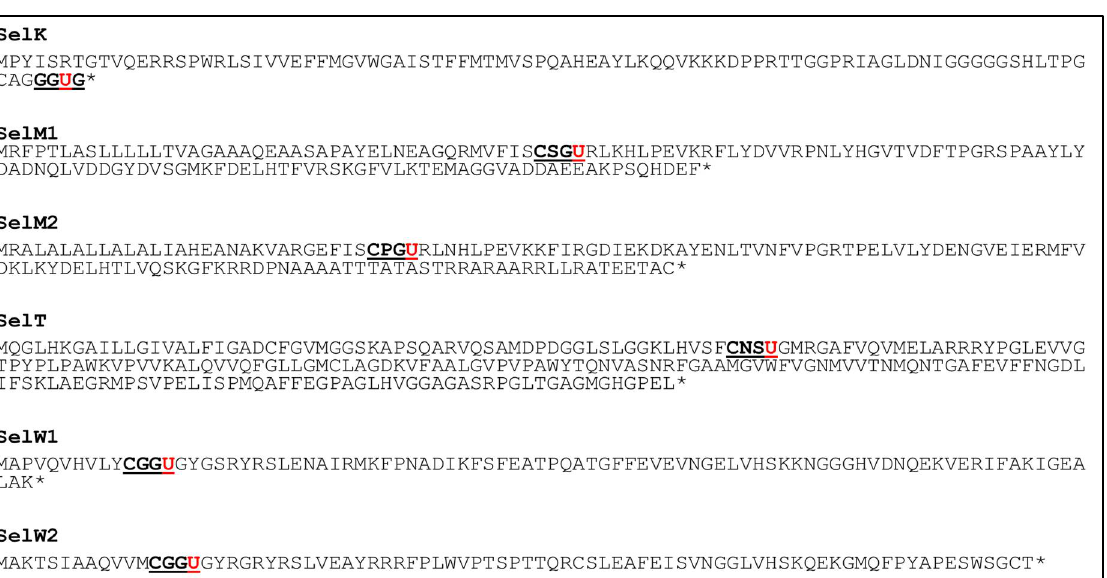
Figure 3. Selenoproteins sequence from Chlamydomonas with conserved catalytic domains. Catalytic domain (CXXU), underscore and bold; Sec (U), underscore and bold in red; *—stop codon.